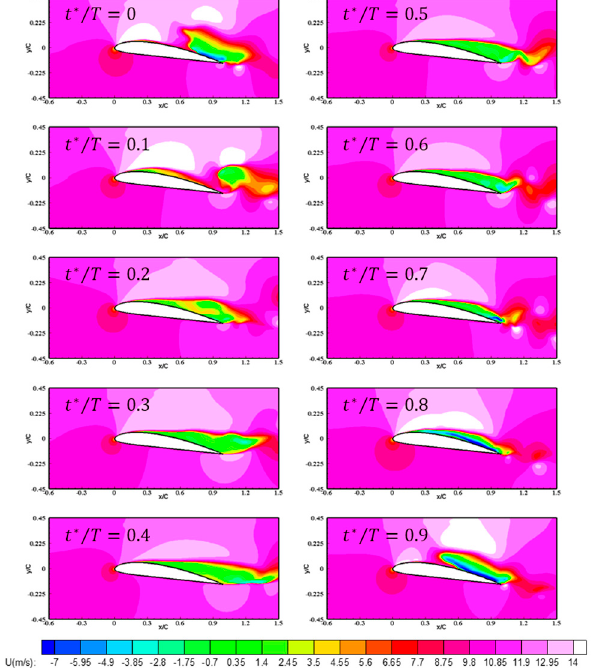
Figure 12. Time-variation of predicted x-directional velocity: viscous lagging case.